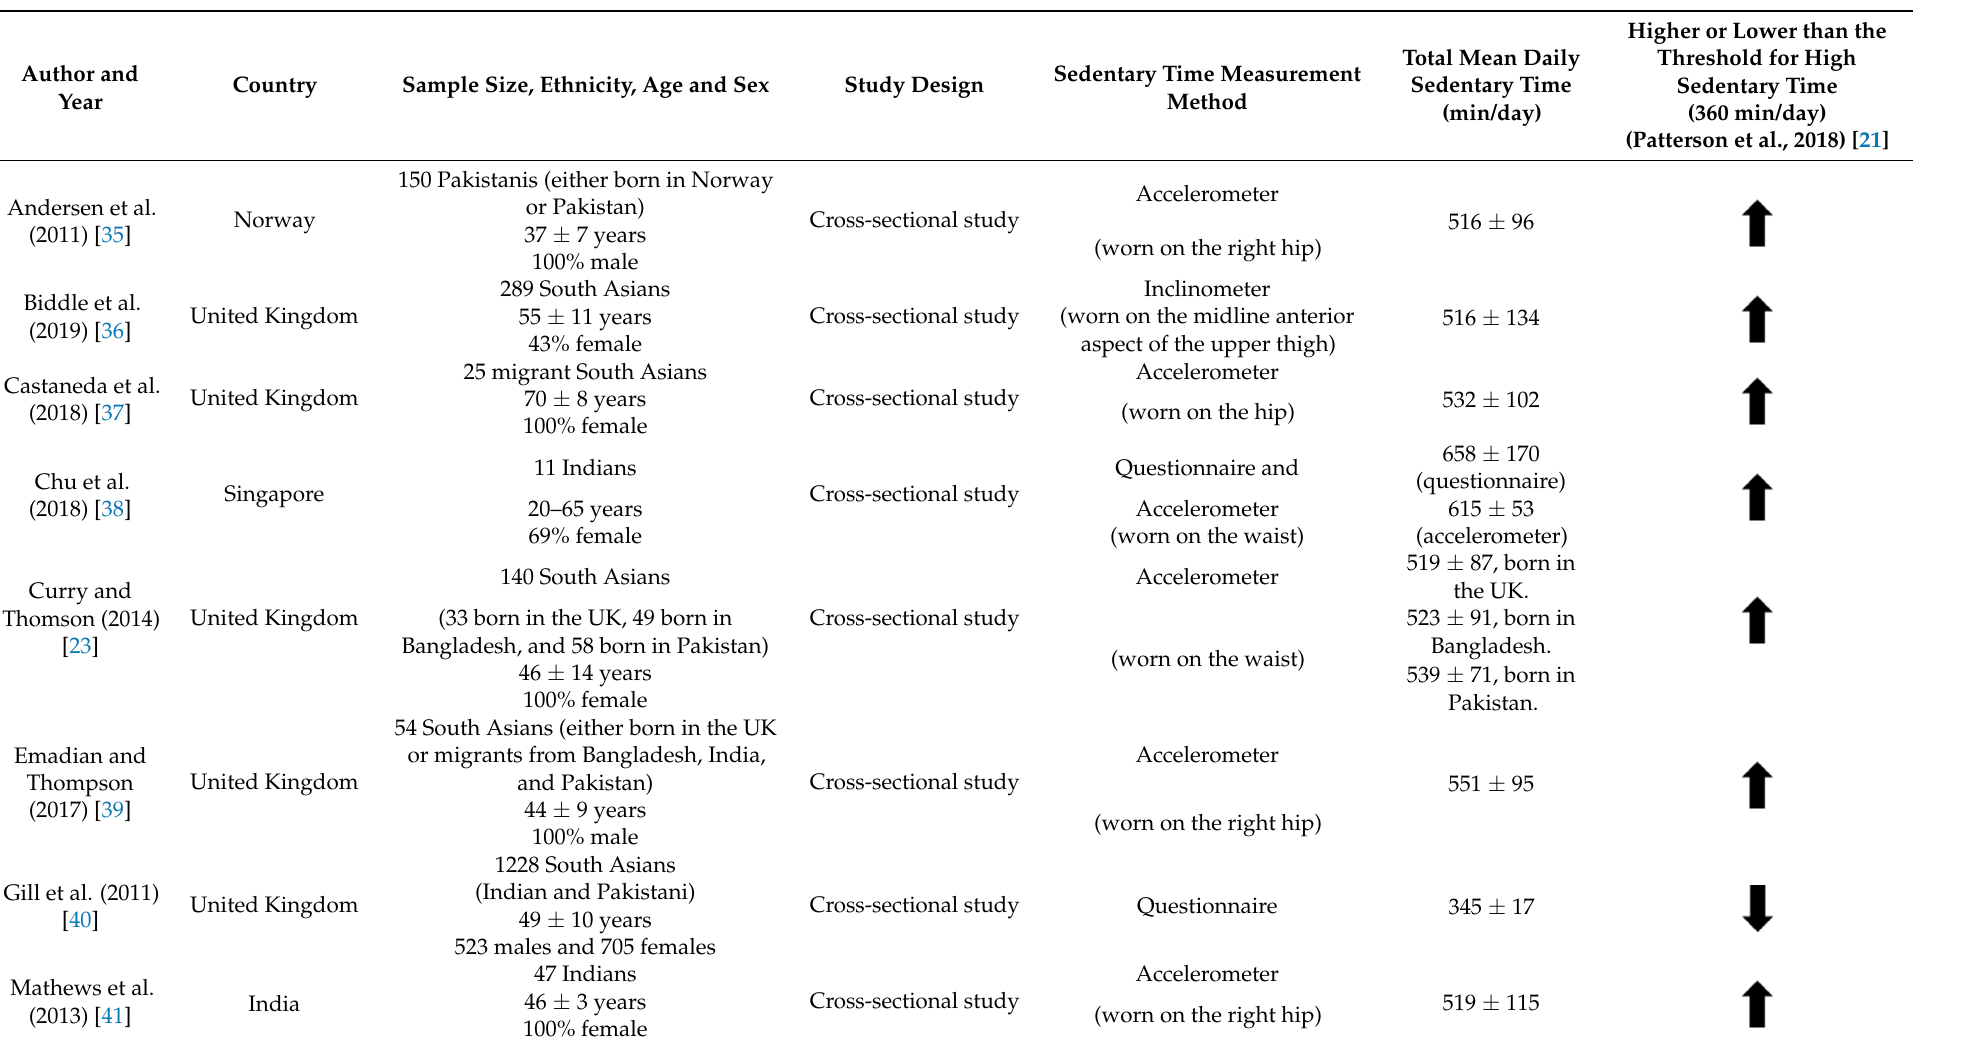
Table 2. Overview of study characteristics.